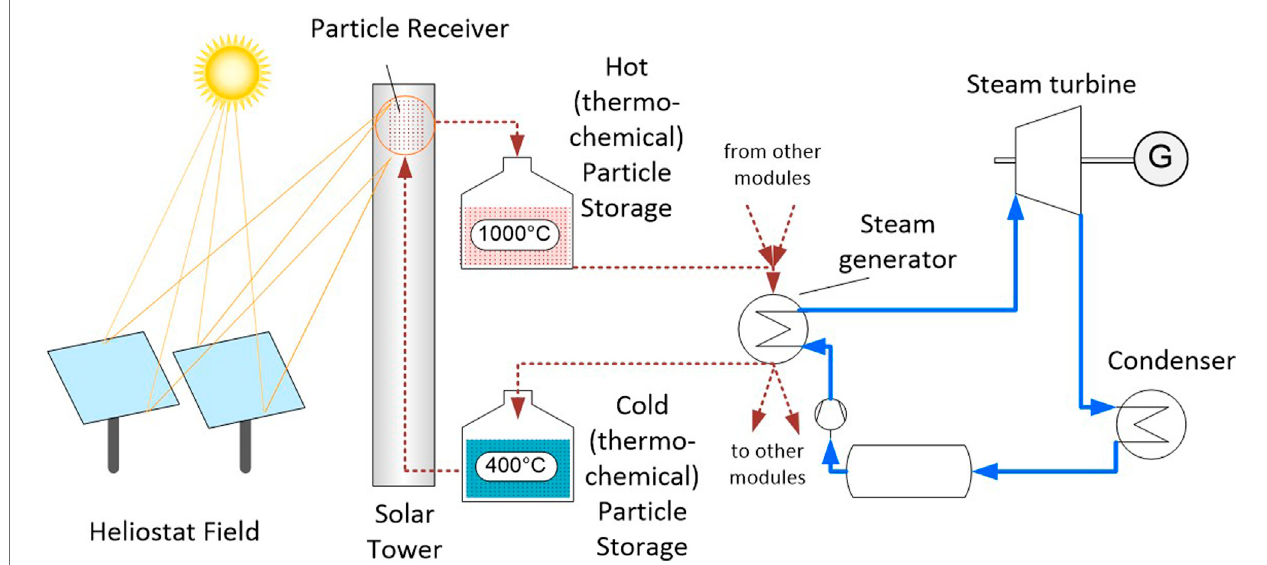
FIGURE 1 | Scheme of the particle-based solar thermal power system (power cycle simpli fi